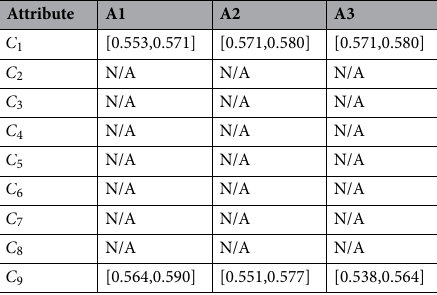
Table 8. Normalized design values (DV) matrix.